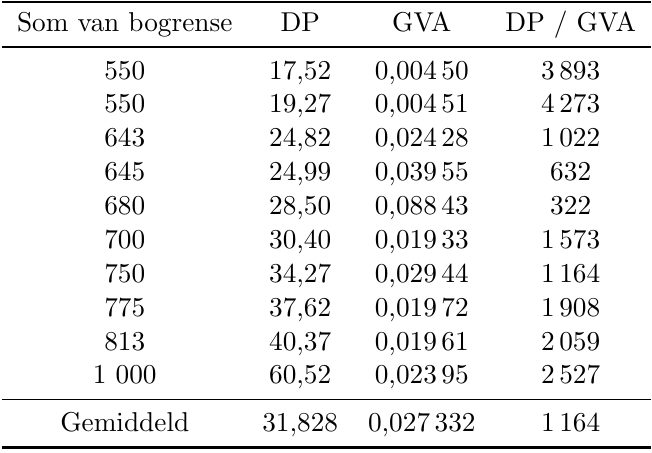
Tabel 3: Berekeningstyd vir enkele toekenning (in sekondes) vir kwadratiese funksies van versa- meling 3, met B = 550